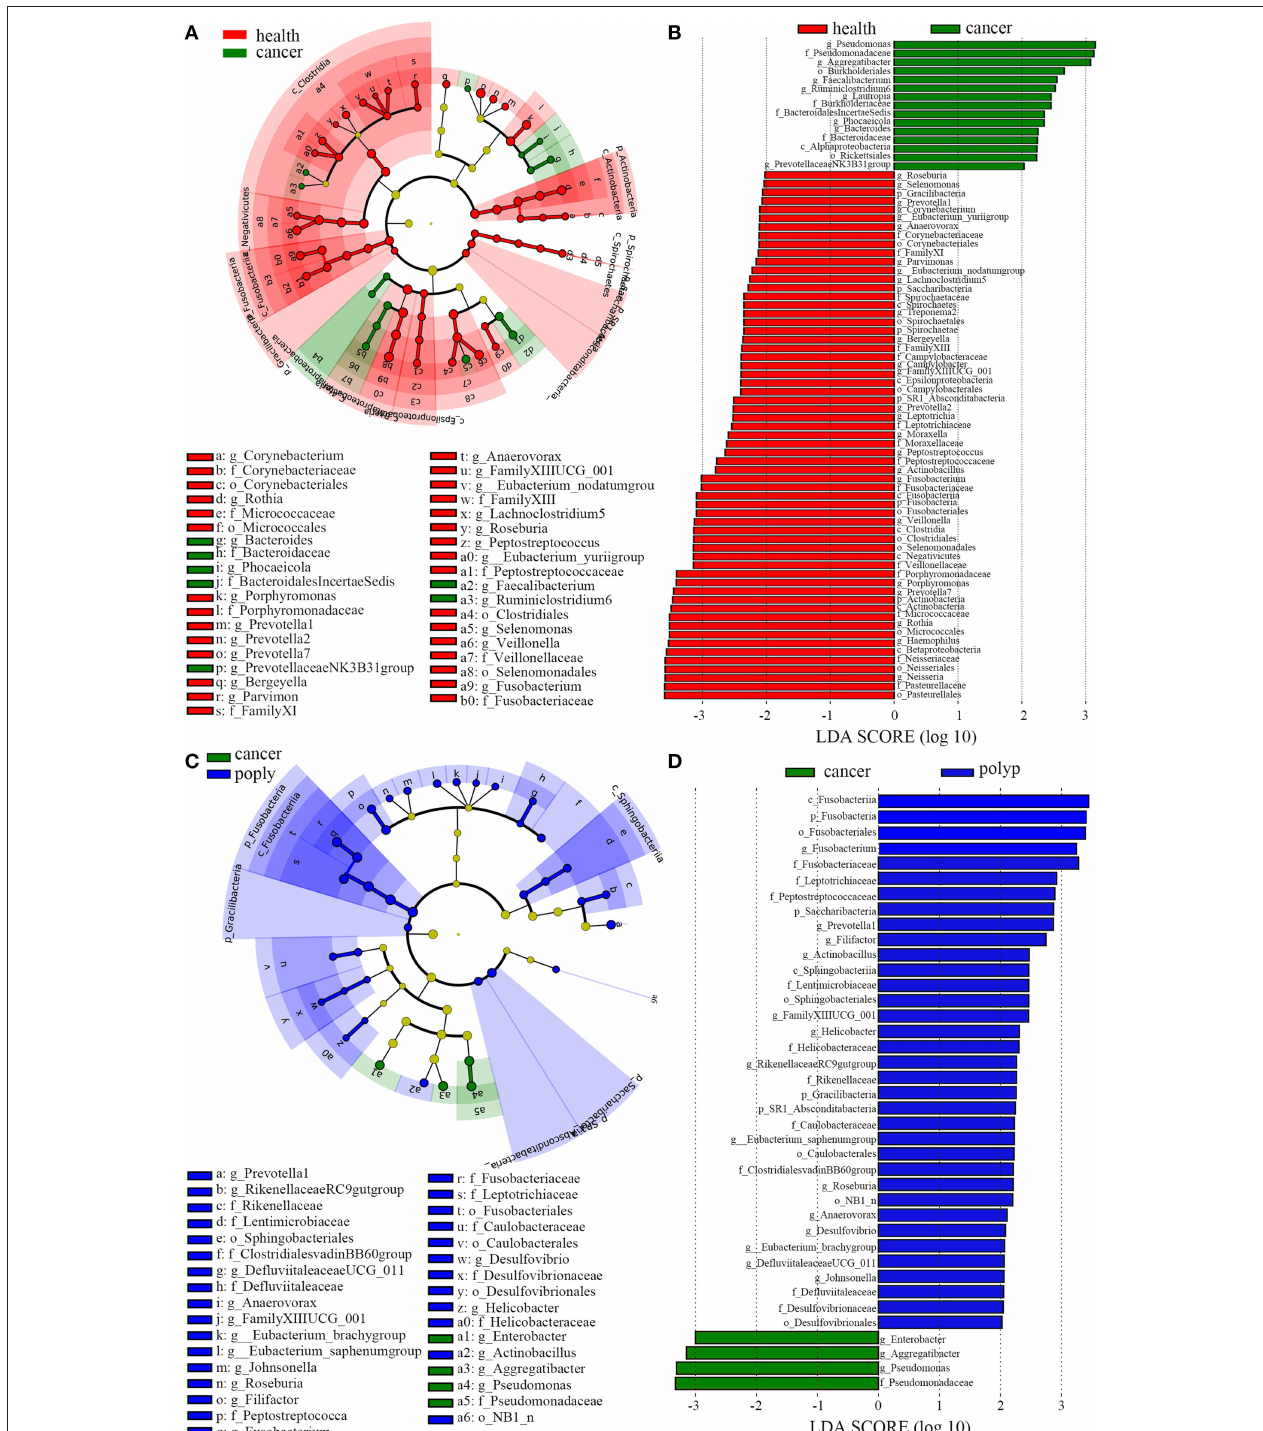
FIGURE 3 | A linear discriminant analysis (LDA) was performed using linear discriminant analysis effect size (LEfSe) with three levels of clinical discrimination categories. (A) Cladogram representation of the oral microbiota taxa in throat cancer patients vs. healthy control individuals. (B) The specific microbiota taxa in throat cancer patients vs. healthy control individuals. Green indicates taxa enriched in the healthy control individuals, and red indicates taxa enriched in throat cancer patients. (C) Cladogram representation of the oral microbiota taxa in the throat cancer vs. the vocal cord polyp group. (D) The specific microbiota taxa in throat cancer patients vs. vocal cord polyp patients. Green indicates taxa enriched in throat cancer patients, and red indicates taxa enriched in vocal cord polyp patients.